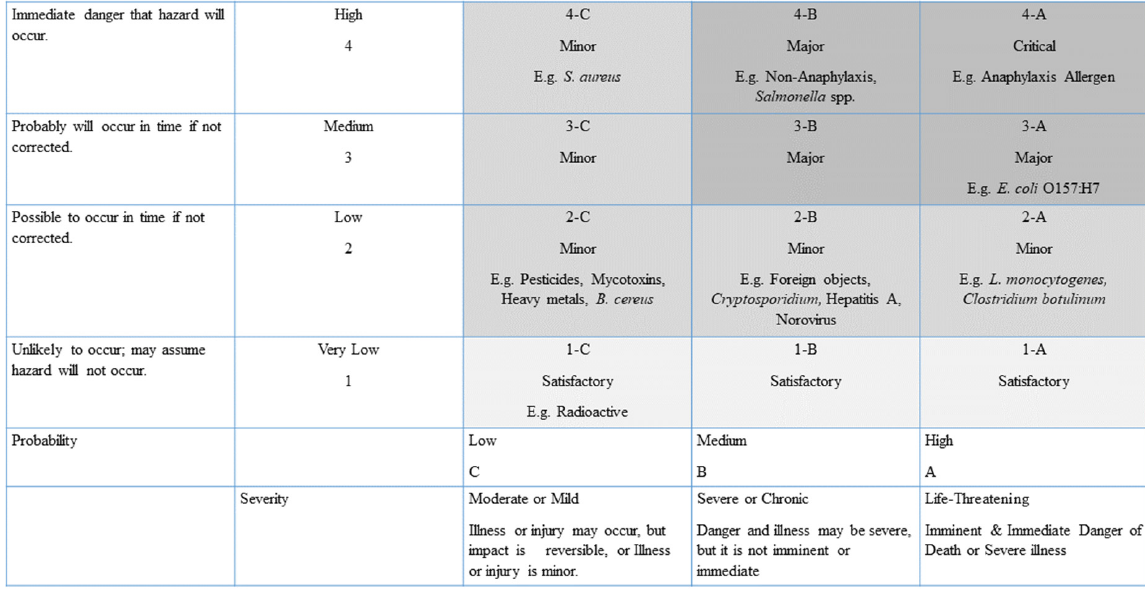
Figure 3. Practical fruit and vegetable 4 × 3 food safety matrix model.